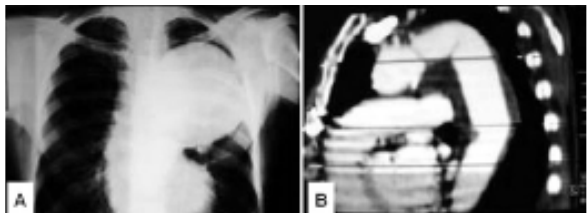
Fig. 2 - A - Radiografia de tórax realizada no período pré-operatório que mostra grande tumoração no mediastino médio e superior, invadindo hemitórax esquerdo. B – Tomografia helicoidal de aorta torácica, demonstrando o aspecto final da aorta torácica